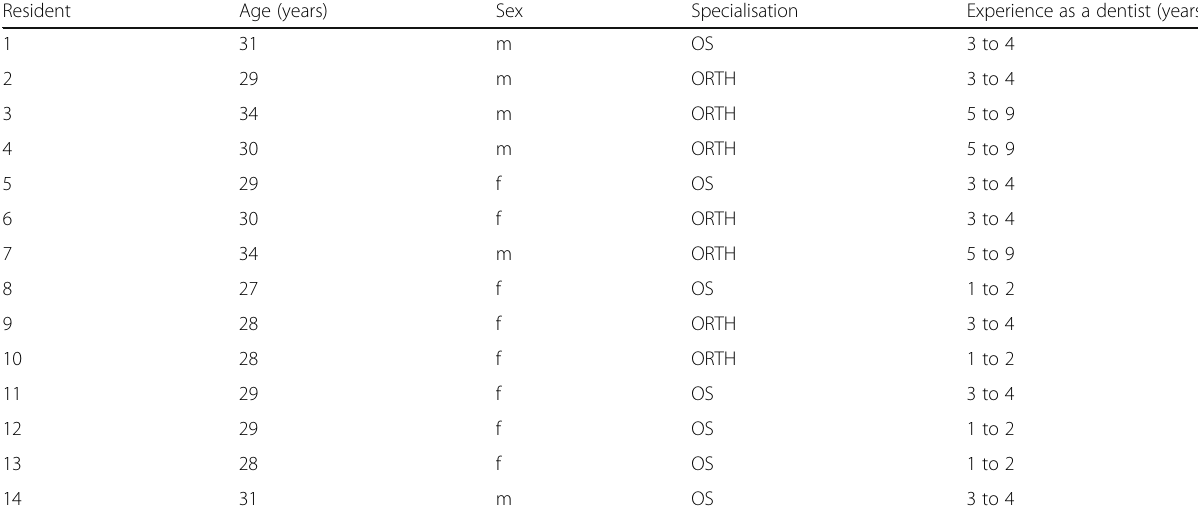
Table 1 Characteristics of residents in oral surgery and orthodontics